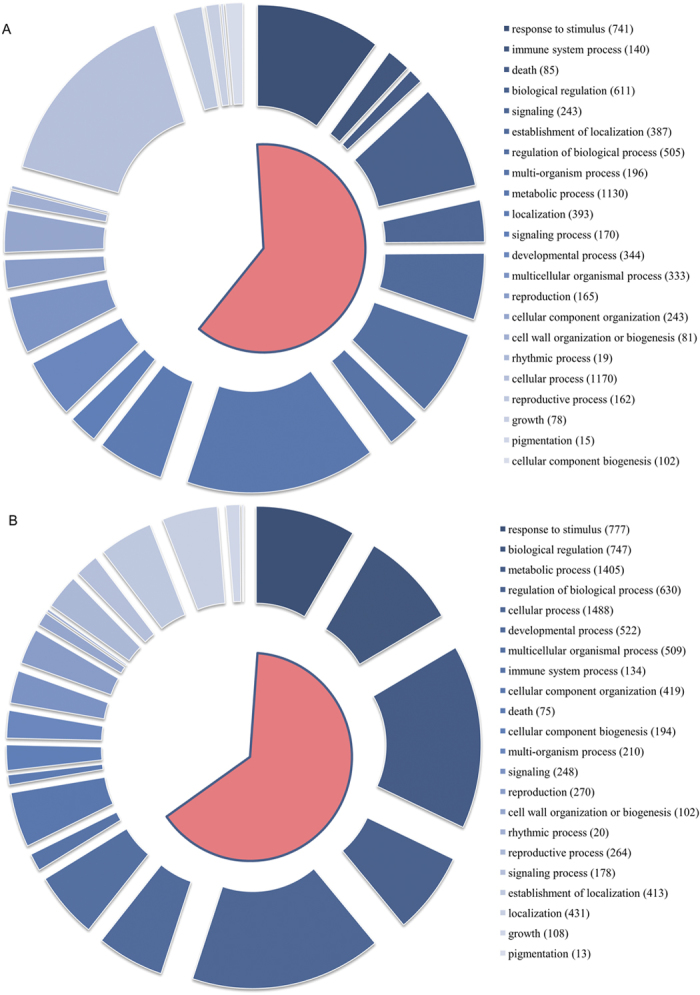
GO category of all DEGs at the second level in roots and leaves.The size of blue block in the outer loop indicates the DEG numbers in each GO term. The color of the outer blue loop indicates the FDR value of the GO term: a deeper color represents a smaller FDR value. The pink range indicates signification enrichment, with FDR ≤0.05 as the cutoff. (A) GO category of DEGs in roots. (B) GO category of DEGs in leaves.